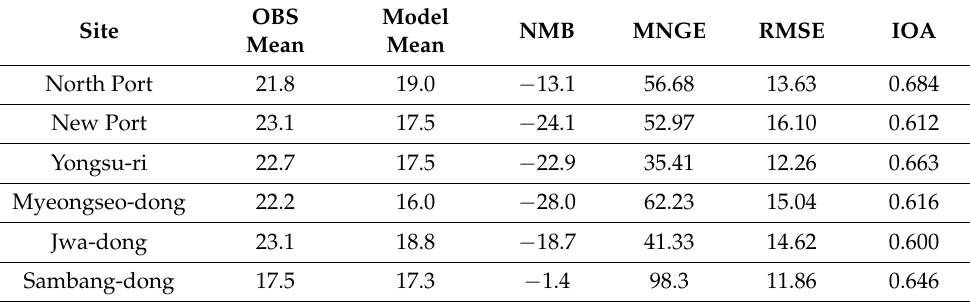
Table 7. Statistical comparison of CMAQ-modeled and AQMS-observed PM 2.5 .